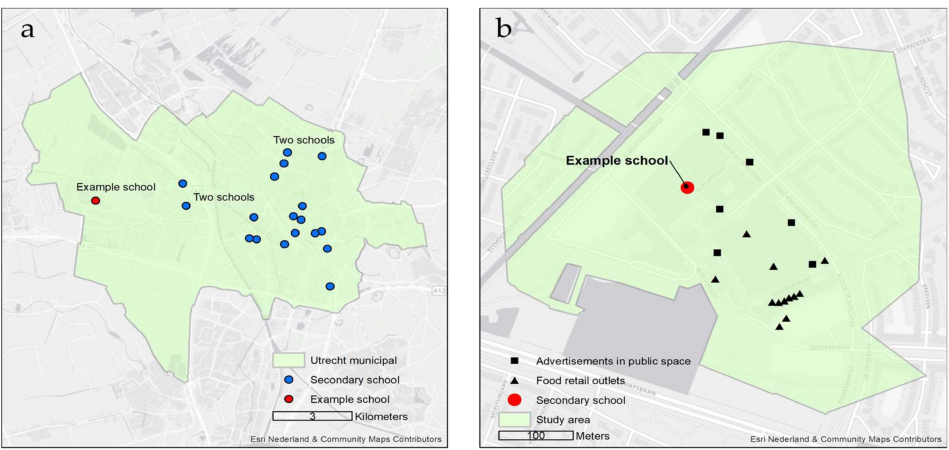
Figure 1. ( a ) All secondary school locations in the Utrecht municipality ( N = 21); ( b ) Example